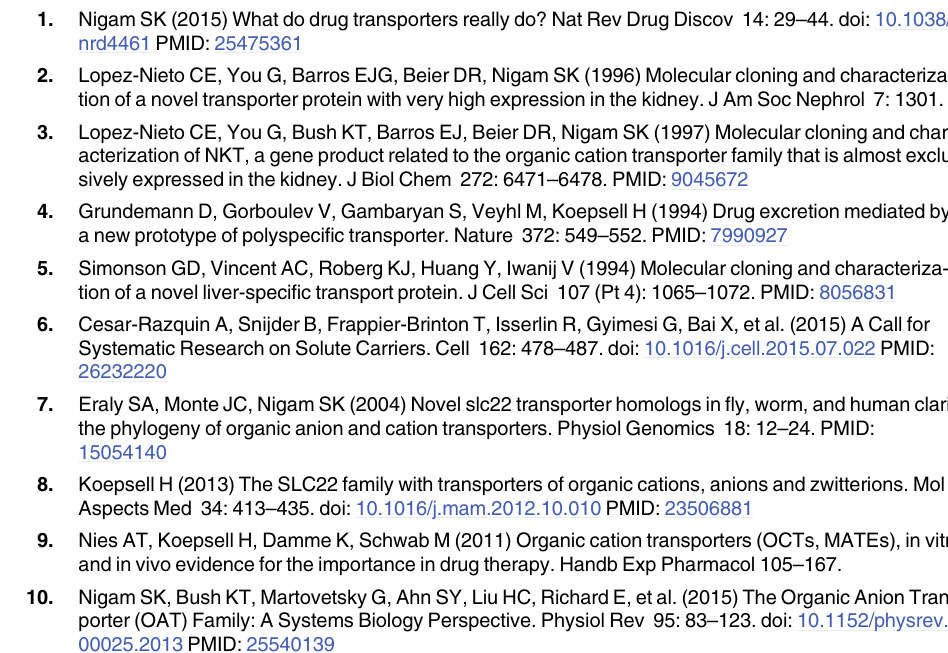
S1 Table. List of Sequences and Accession Numbers for Generating Fig 1, Supplemental S1 and S2 Figs. S2 Table. Evolutionarily Conserved Motif Sequences. S3 Table. Clade Specific Sequences. S4 Table. Specific Residue Information. S5 Table. MEME